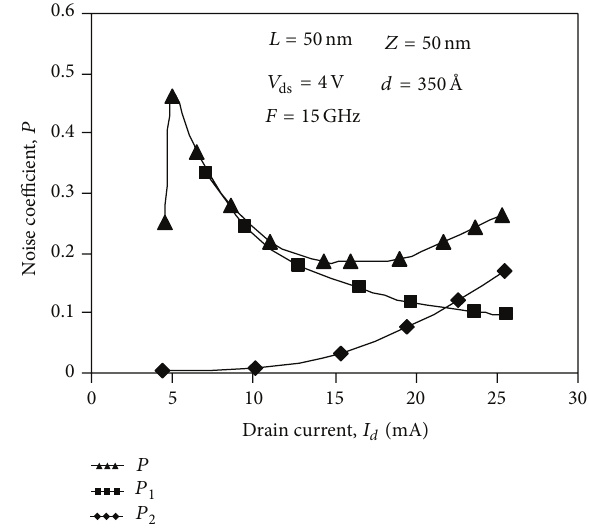
Figure 10: Variation of PAE, gain, and output power with input power.